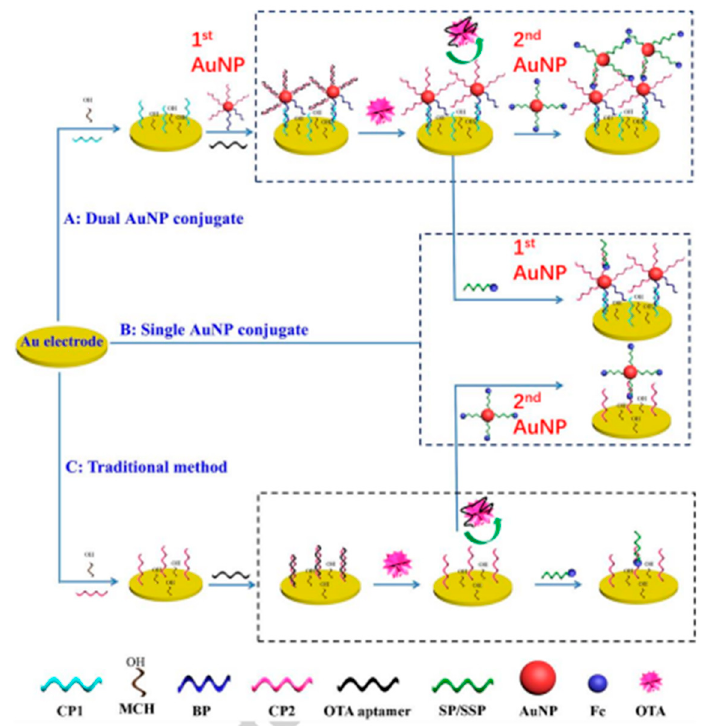
Figure 11. Schematic diagram of the ( A ) Dual AuNP conjugates, ( B ) Single AuNP conjugates, and ( C ) Traditional method (non-AuNPs)-based electrochemical aptasensors for amplified assay of OTA. Reproduced from [41]. Copyright 2018 Elsevier.